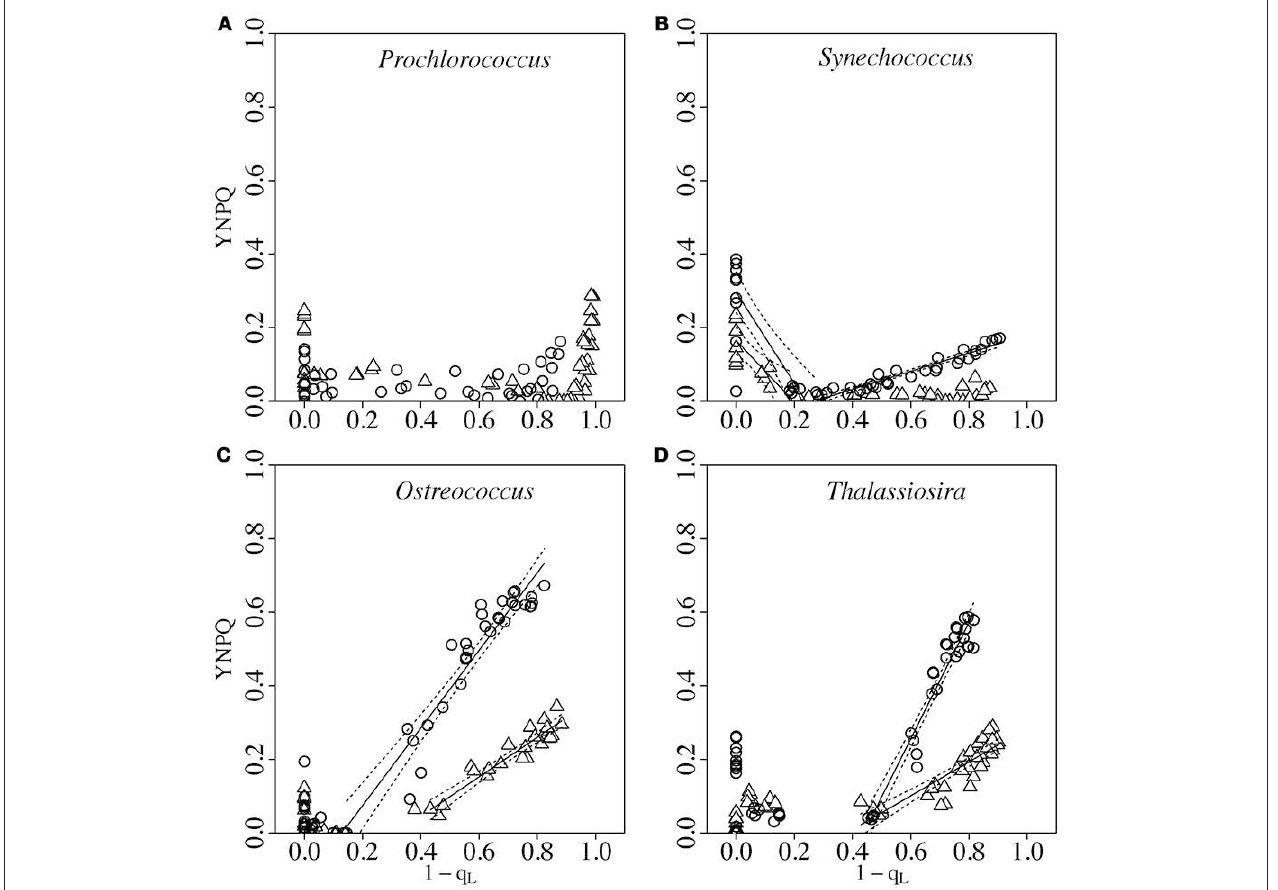
FIGURE 3 | Response of YNPQ to progressive closure of Photosystem II (1-q L ) in Prochlorococcus (A) , Synechococcus (B) , Ostreococcus (C) or Thalassiosira (D) from growth-limiting (open triangles) or growth saturating light (open circles). Photosystem II closure was driven by increasing actinic light ( Figure 1A ). Paired determinations from 4 to 8 replicate cultures plotted individually. Solid lines show segmented linear regressions to determine the break point for induction of YNPQ and the response of YNPQ to increasing Photosystem II closure. Dotted lines show 95% C.I. on the regression